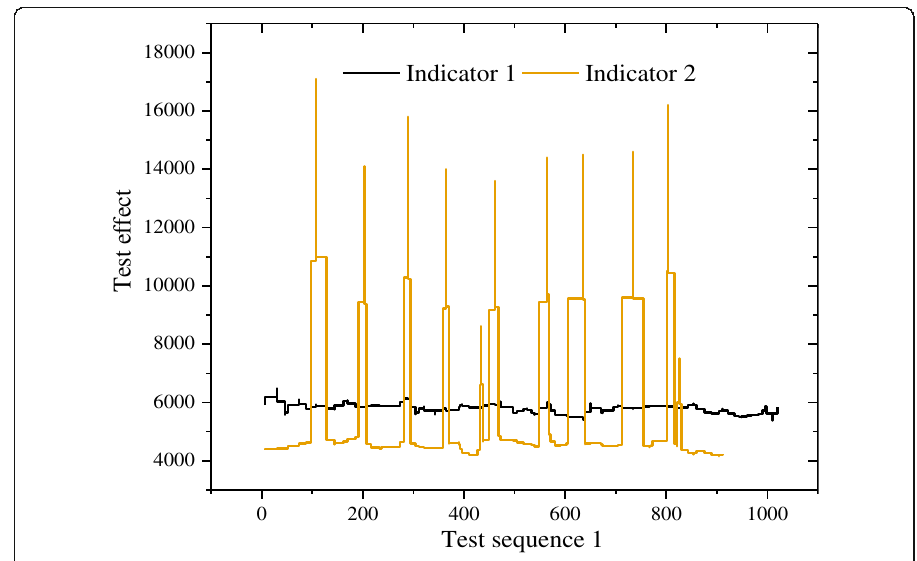
Fig. 3 Network transmission simulation test during swimming dynamics transmission